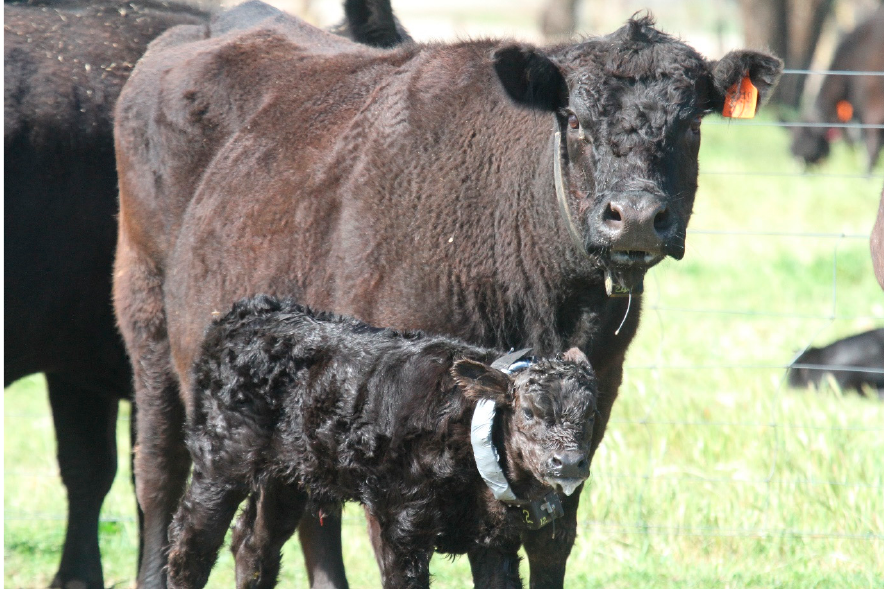
Figure 4. Mature Angus beef cow and her calf with deployed proximity logger collars.